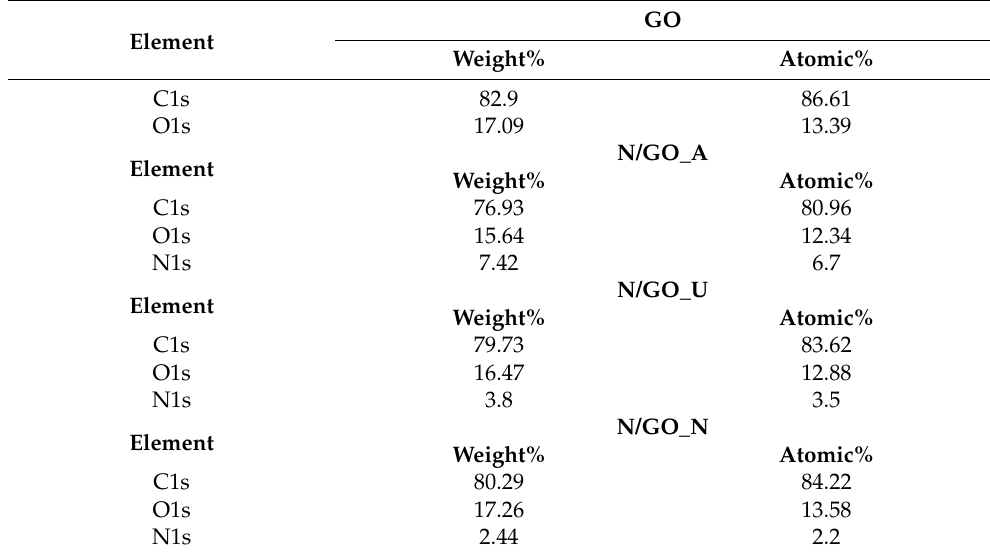
Figure 6. XPS high resolution spectra for nitrogen-doped graphene oxide synthesized using nitric acid (N/GO_N); ( a ) Carbon (C1s); ( b ) Oxygen (O1s); ( c ) Nitrogen N1s. Table 3. XPS quantitative analysis—composition